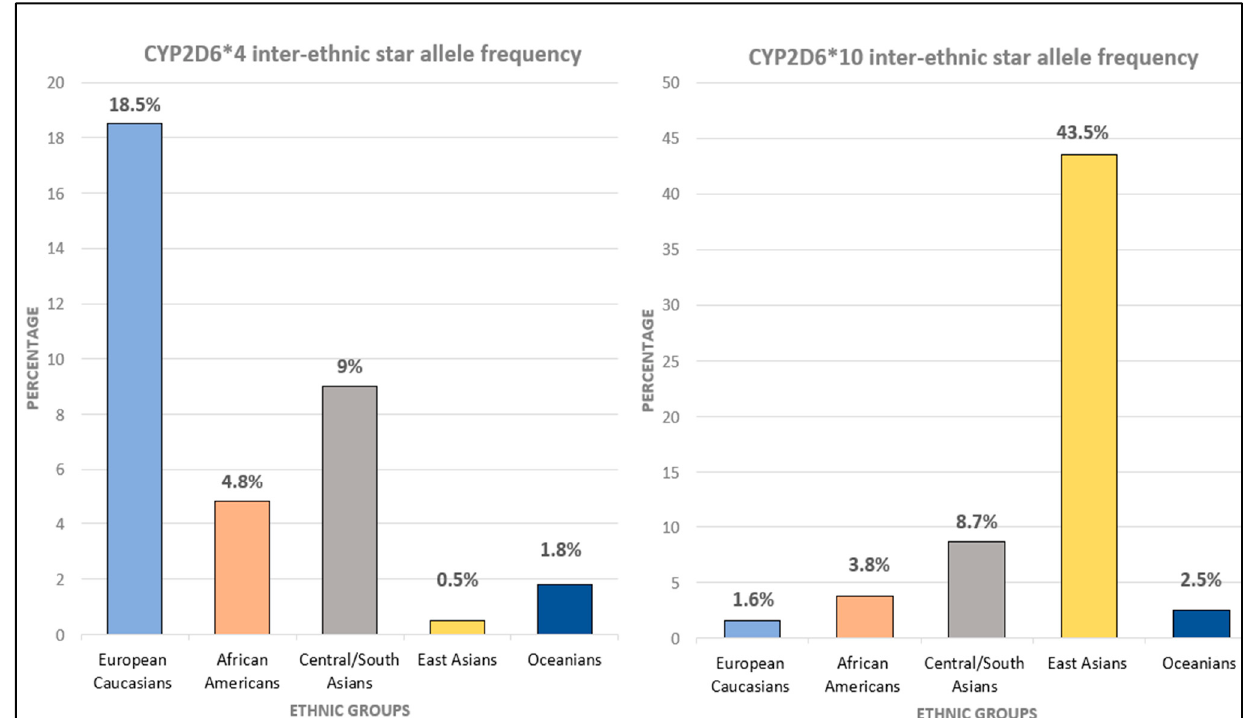
Figure 2. CYP2D6 inter-ethnic star allele frequency (https://www.pharmgkb.org/page/cyp2d6RefMaterials, PharmGKB) accessed on 8 February 2022, [114].